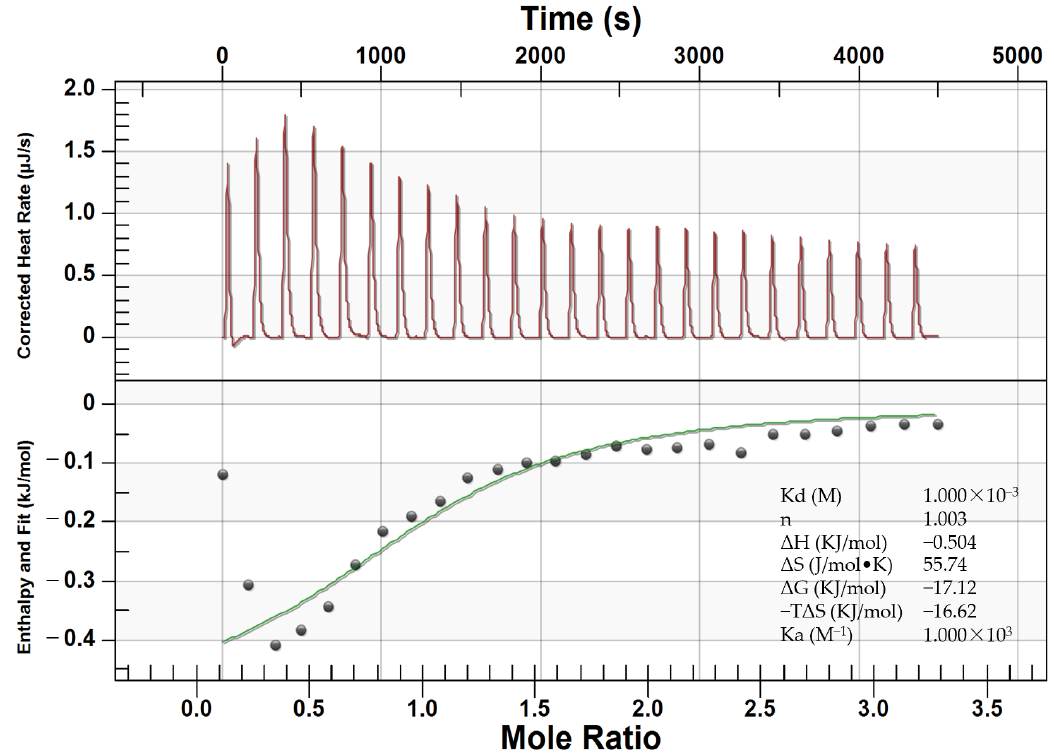
Figure 1. Thermodynamics of binding interactions between Glu-Phe ARPs and β -CD as measured using ITC. The upper panel displays a representative calorimetric titration curve. The lower panel exhibits a fitted curve based on an independent binding model.